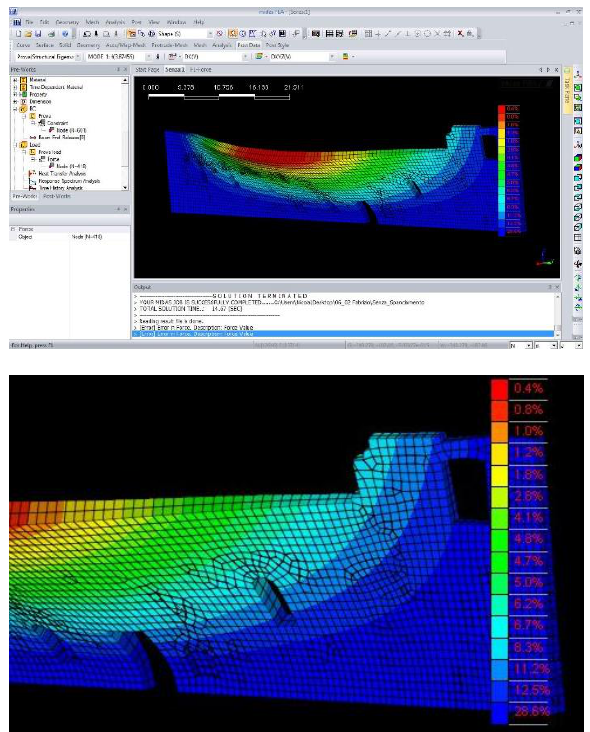
Figure 11. 3D representation of the stone ashlars of the columns, surveyed using both laser scanner and direct